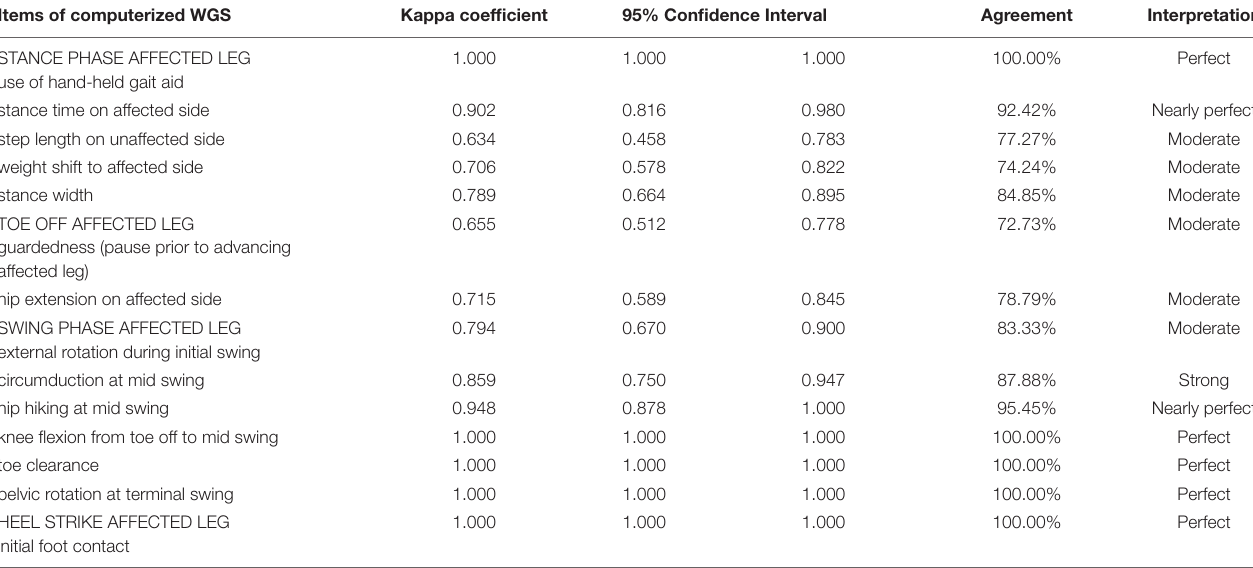
TABLE 5 | Comparison of measurements performed by three different examiners (interrater reliability), in both examinations. Items of computerized